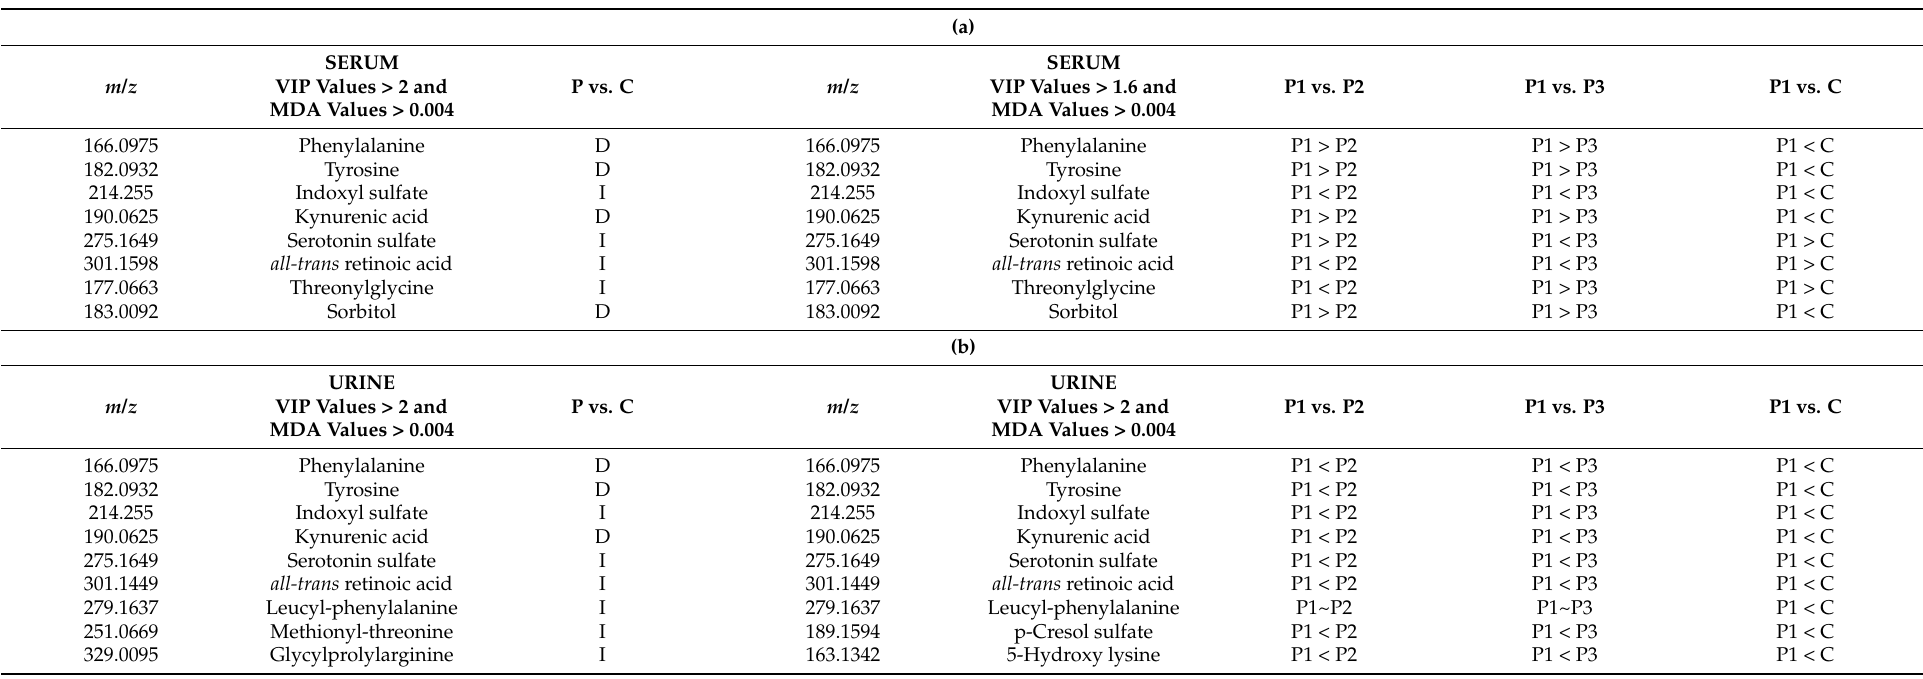
Table 1. ( a ) Main serum metabolites to be considered as potential biomarkers of discrimination between healthy and DKD patient group, as such or between the subgroups P1, P2 and P3. The variations, e.g., increases (I) or decreases (D), are also described. ( b ) Main urine metabolites to be considered as potential biomarkers of discrimination between healthy controls (C) vs. DKD group (P), and between healthy controls C vs. subgroups P1, P2 and P3. The variations, e.g., increases (I) or decreases (D), are also